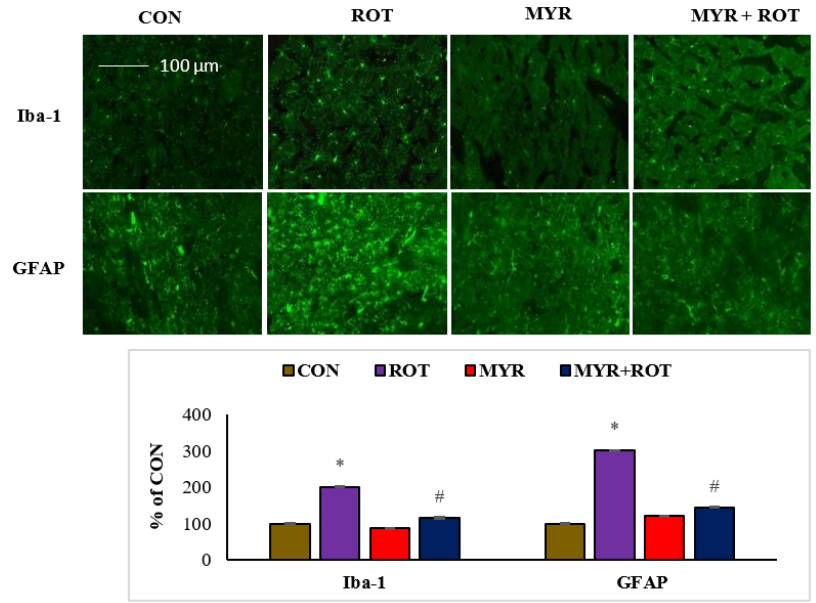
Figure 4. The effect of myrcene on activation of glial fibrillary acidic protein (GFAP) positive astrocyte (green) and ionized calcium binding adaptor molecule-1 (Iba-1) positive microglia (green) in the striatum. Scale bar: 100 µM. The values are expressed as percent mean ± SEM ( n = 3). * p < 0.05 (ROT vs. CON), # p < 0.05 (MYR vs. ROT).